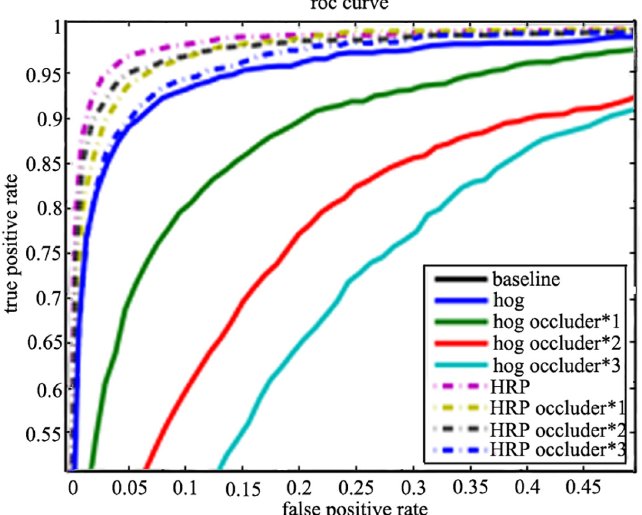
Fig 6. The performance of the proposed IHRP in the case of